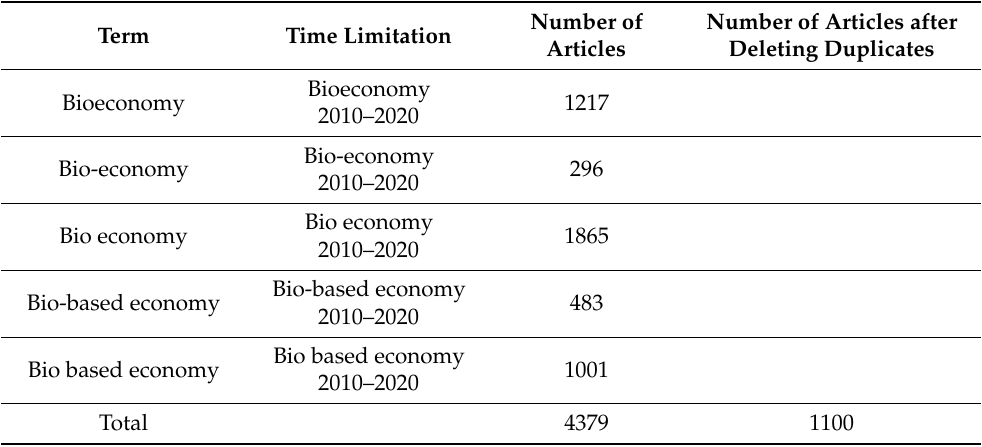
Table 1. Alternative wording of the term